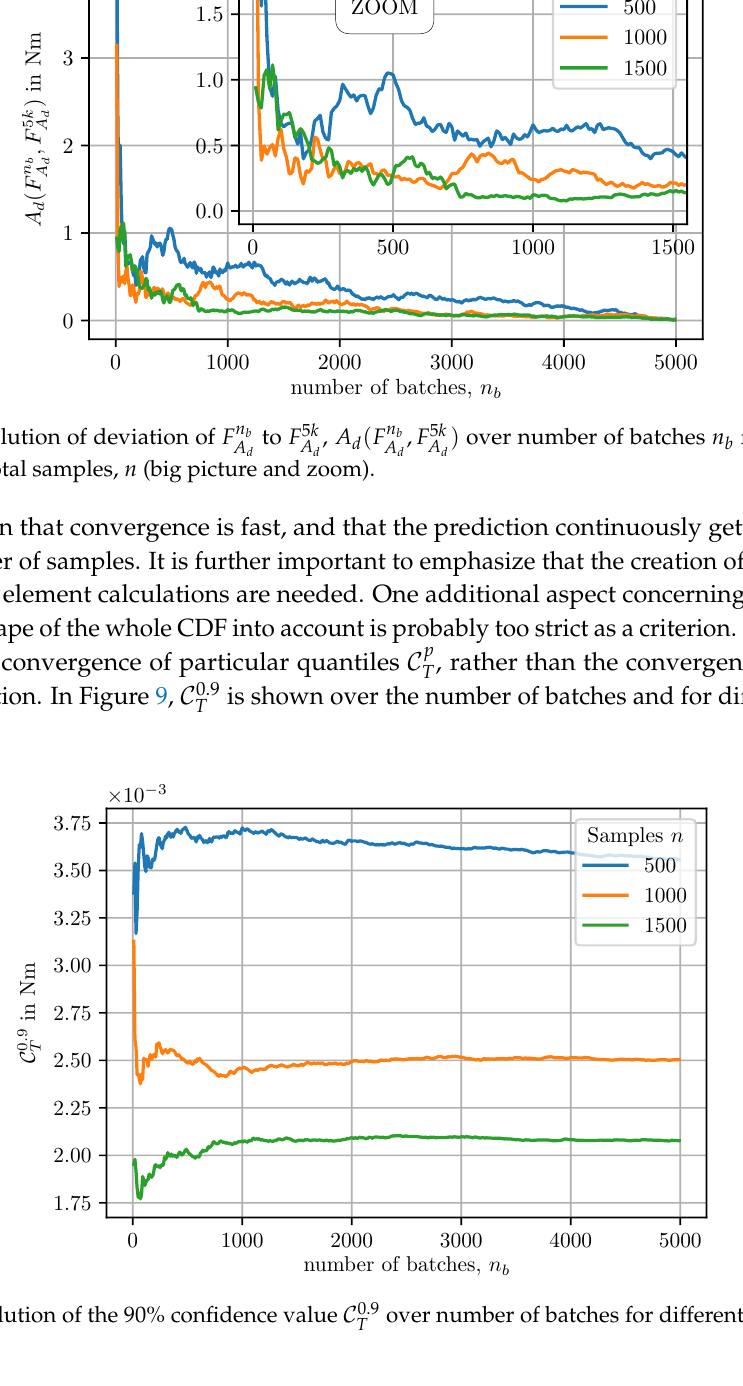
Figure 9. Evolution of the 90% confidence value samples, N s